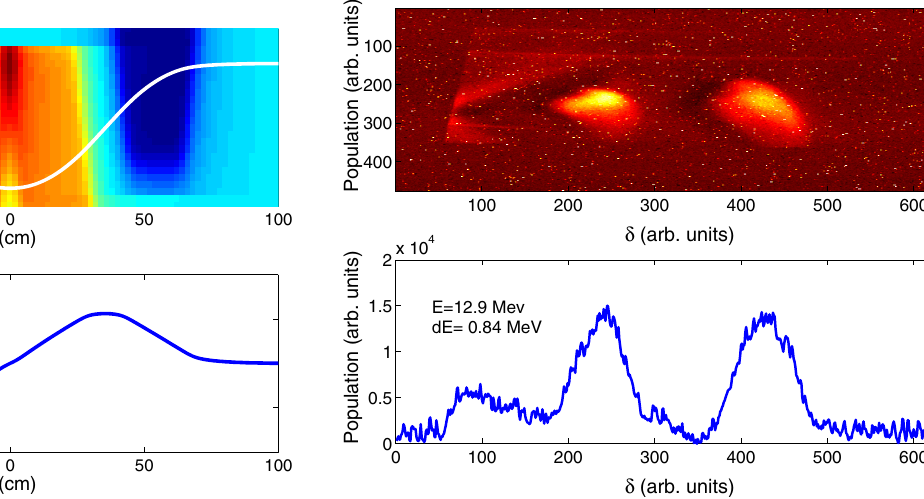
Table I. For each beam-energy setting, the initial macro- particle time separation (cid:1) (cid:7) and the corresponding energy i separations (see example in Fig. 7) were measured with the bunch compressor turned off. The bunch-compressor di- poles were then set to their nominal values and the macro- particle time separations downstream of the compressor was measured. For the setting corresponding to maxi- (cid:1) (cid:7) f mum compression ( E (cid:2) 12 : 9 MeV ), the phase of the boos- ter cavity was tuned so as to cause the two macroparticles to overlap in time. Apart from the maximum-compression case ( (cid:1) 35 (cid:5) ), we used the phase settings of (cid:6) 20 (cid:5) off crest. For the latter cases, the change in time of macroparticle separation is only a factor of 3 bigger than the streak camera instrumental error. The values of R , directly 56 estimated from Eq. (9), are gathered in Table II along with simulation results. In general the agreement between simulation and experiment is good. The measurement, however, suffers from large error bars away from the maximum-compression phase. These large error bars are mainly due to the streak camera resolution (2 ps), and could be significantly reduced by using state-of-art streak cameras with (cid:4) 200 fs resolution.